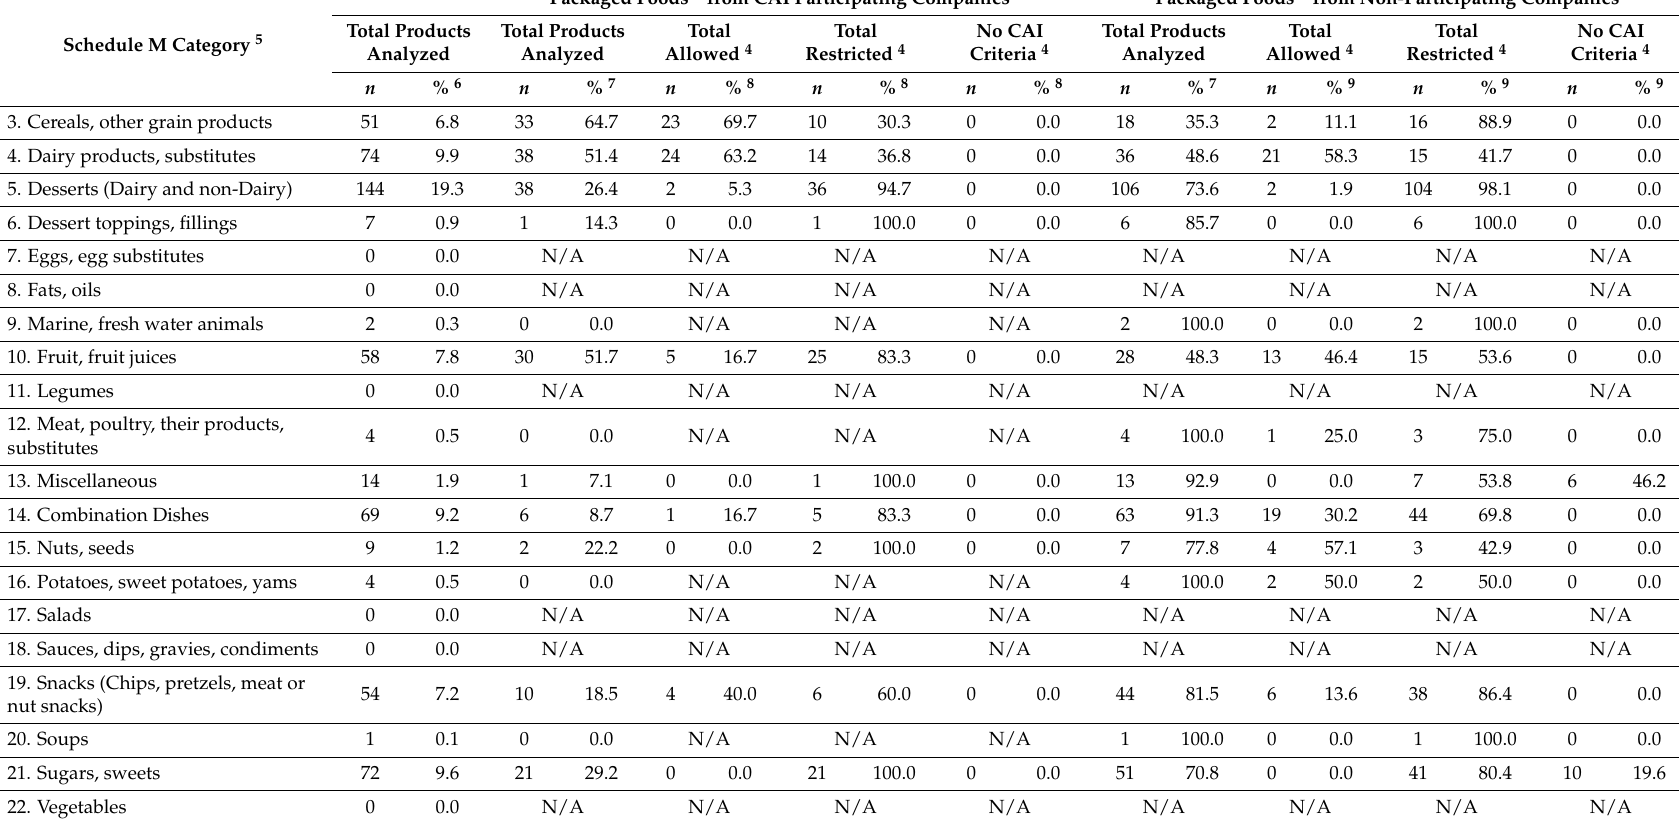
Advertising Initiative’s (CAI) Uniform Nutrition Criteria are defined in: Advertising Standards Canada. Canadian Children’s Food and Beverage Advertising Initiative ; Uniform Nutrition Criteria White Paper; September 2014 [17]. 5 Food categories are defined in Schedule M of the Food and Drug Regulations (C.R.C., c. 870), Sections B.01.001, B.01.002A and D.01.001, Government of Canada, Health Canada [21]. 6 Percentage of total products (i.e., out of n = 747 products). 7 Percentage of total products in that food category. 8 Percentage of products from CAI participating companies in that food category. 9 Percentage of products from non-participating companies in that food